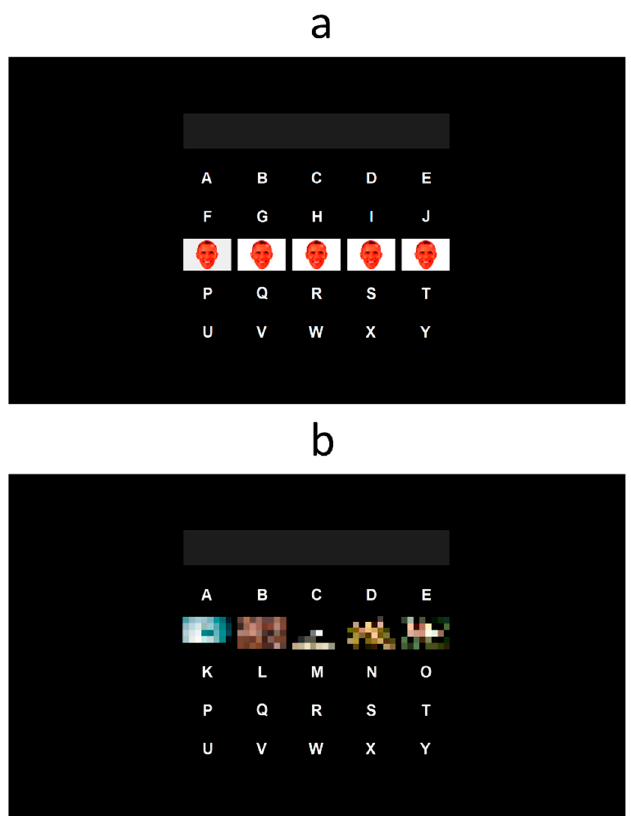
Figure 1. Two spelling paradigms were tested in the experiment, which varied in terms of the flashing stimulus used: ( a ) famous faces shown in red with a white rectangle (RFW), based on [4]; and ( b ) neutral pictures (NP), based on [19]. For copyright reasons, the neutral pictures have been pixelated here.